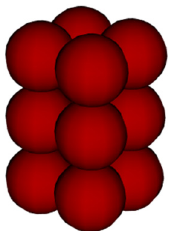
Figure 10. Illustration of a structure of assembled chiral particles composed in a 2 × 2 × 3 square array. The RCS of a 2 × 2 × 3 array of 12 chiral spheres with different material losses induced by a 632.8-nm first-order Bessel beam propagating along the angle of α = 30 ◦ from the + Z axis of the chiral sphere to be from 2.0 + 0.0 i to 2.0 + 1.5 i , and kept the other parameters fixed.